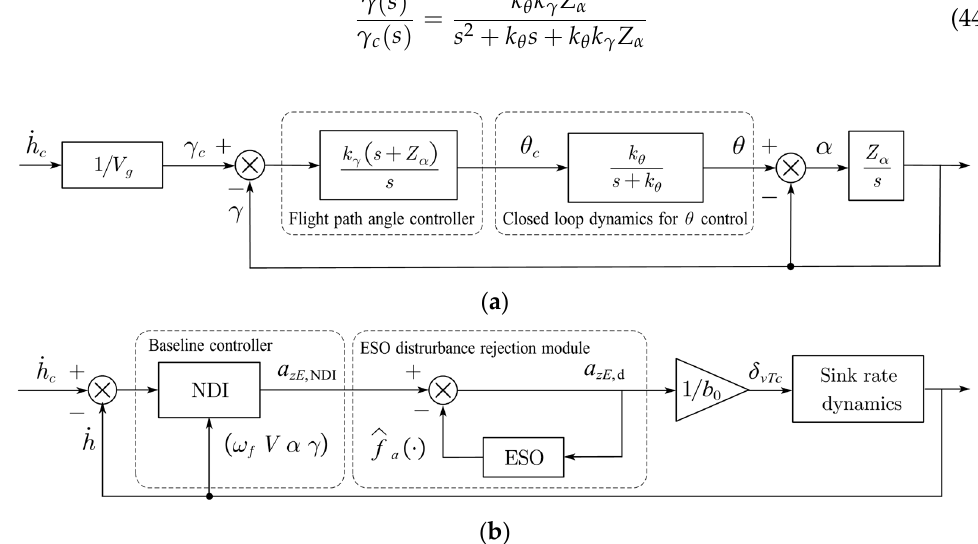
Figure 17. Sink rate control diagram: ( a ) control sink rate obtained using pitch attitude angle and ( b ) control sink rate obtained using the throttle.